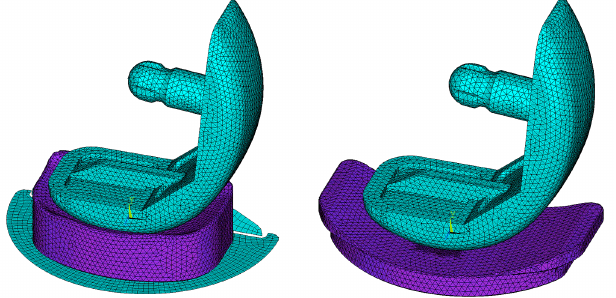
Fig.5. Meshed models of the both unicondylar knee re- placement types